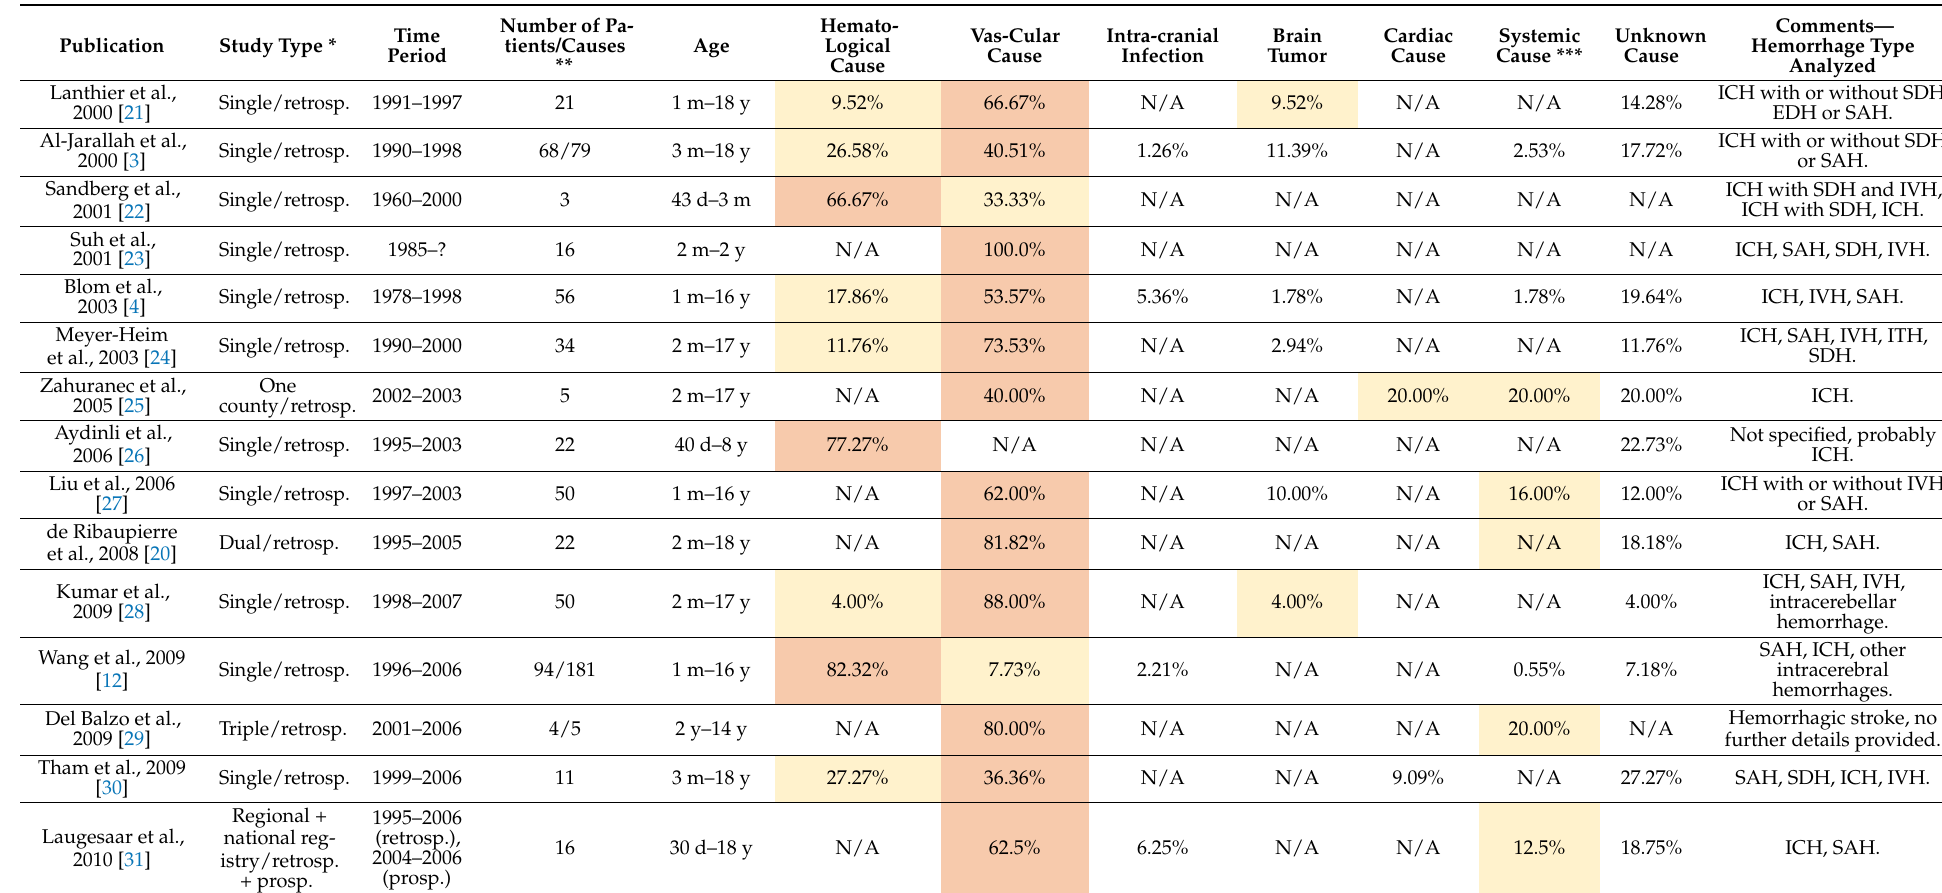
Table 1. Number of patients with different etiology- and risk factor categories in each of the included studies. Study type, time span, age of study participants and types of intracranial hemorrhages analyzed in each of the included articles are also provided. The most common and the second most common causes of spontaneous intracranial hemorrhage in each study are marked with brown and yellow colors, respectively. Abbreviations: N/A—not applicable, ICH—intracerebral